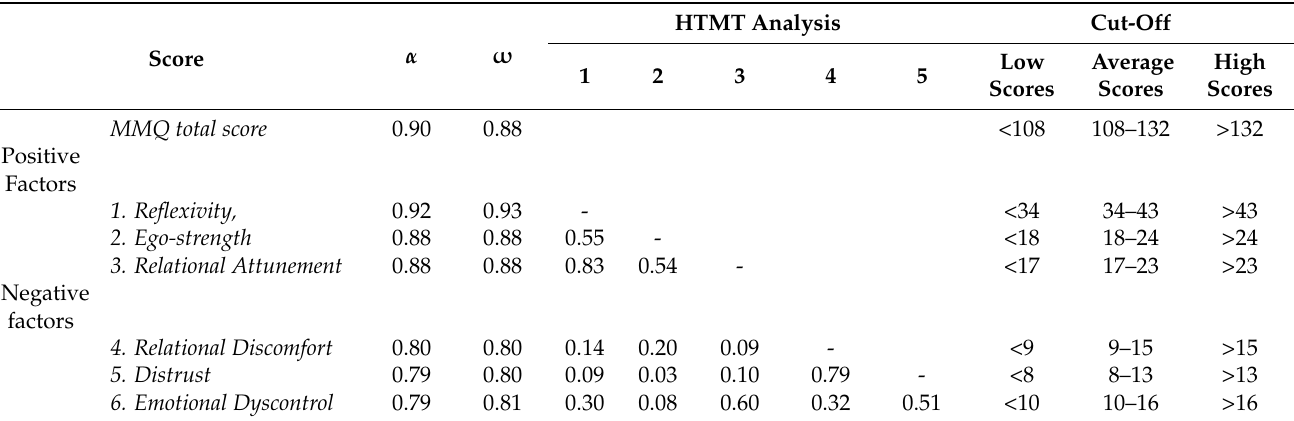
Table 3. Indications of internal consistency, MMQ factors’ heterotrait-monotrait ratio of correlations (HTMT), and cut-off points.